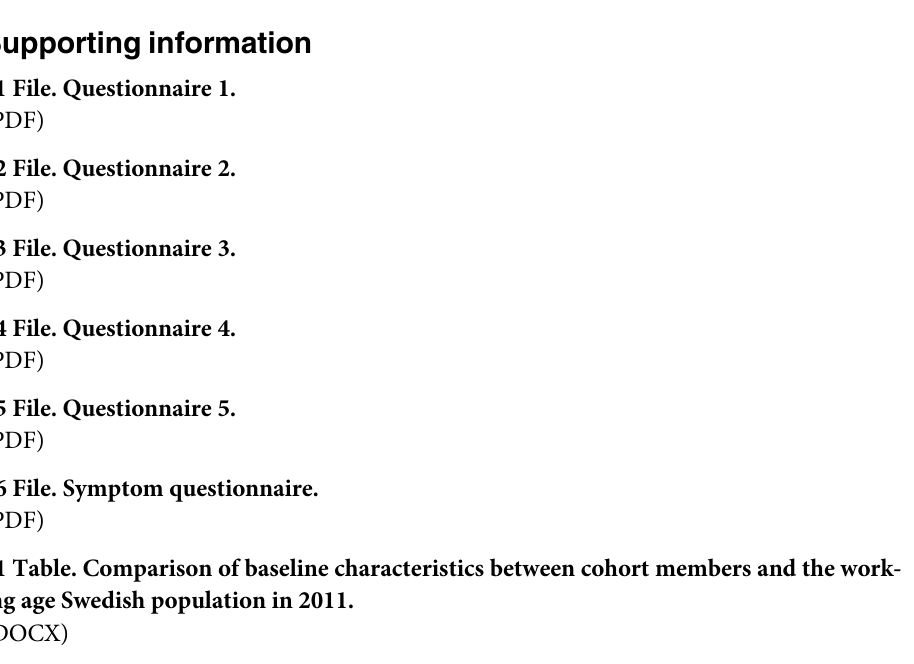
S1 Table. Comparison of baseline characteristics between cohort members and the work- ing age Swedish population in